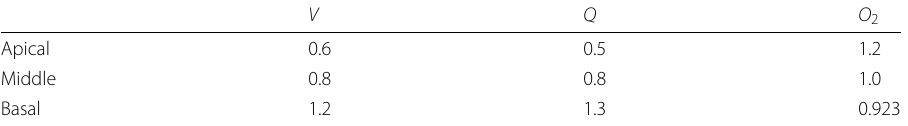
Table 2 Values for attributes of West Zones used in simulations of multi-patch topology model, unless specified in the text V Q O 2 Apical 0.6 0.5 1.2 Middle 0.8 0.8 1.0 Basal 1.2 1.3 0.923 V = Ventilation, Q = Perfusion, O 2 = Oxygen